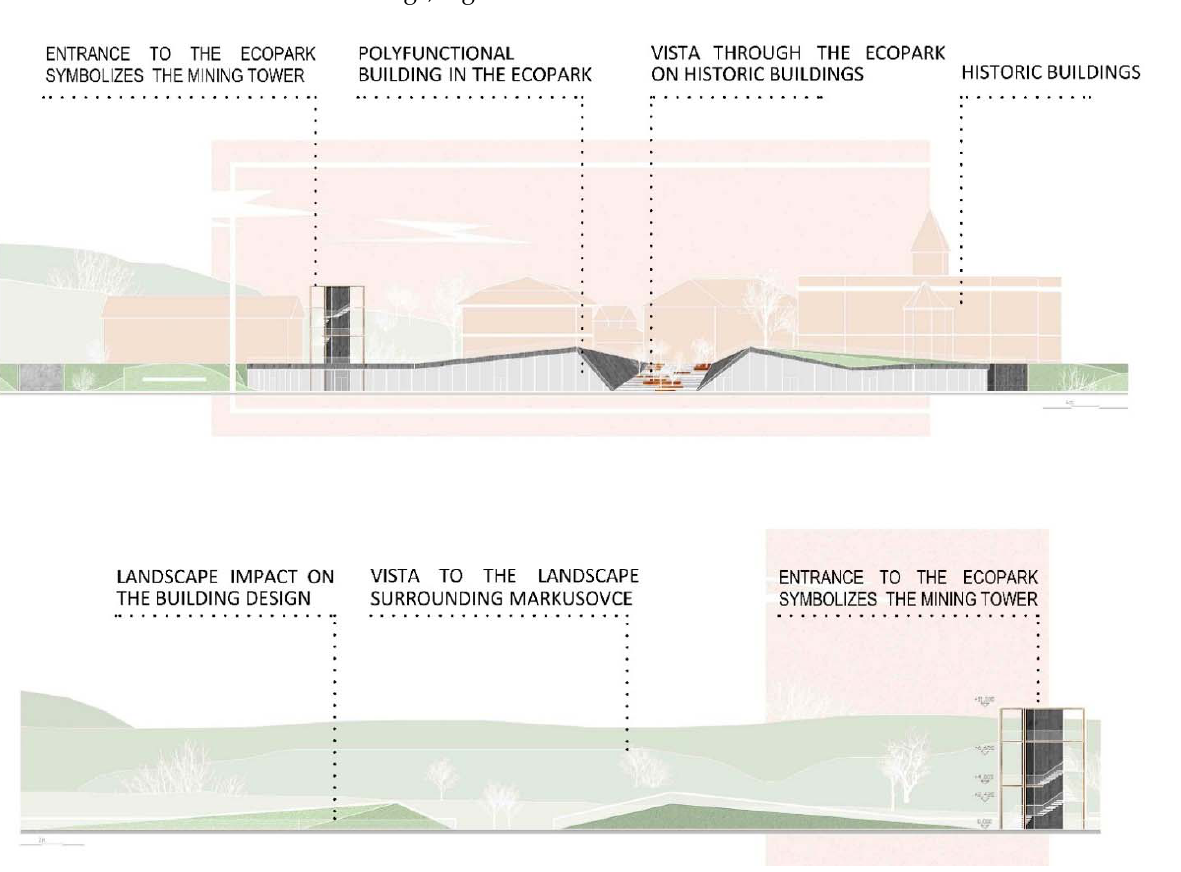
Figure 10. The concept highlighting the landscape, Case Study 1a—views (author’s design studio, D. Glo č áková).